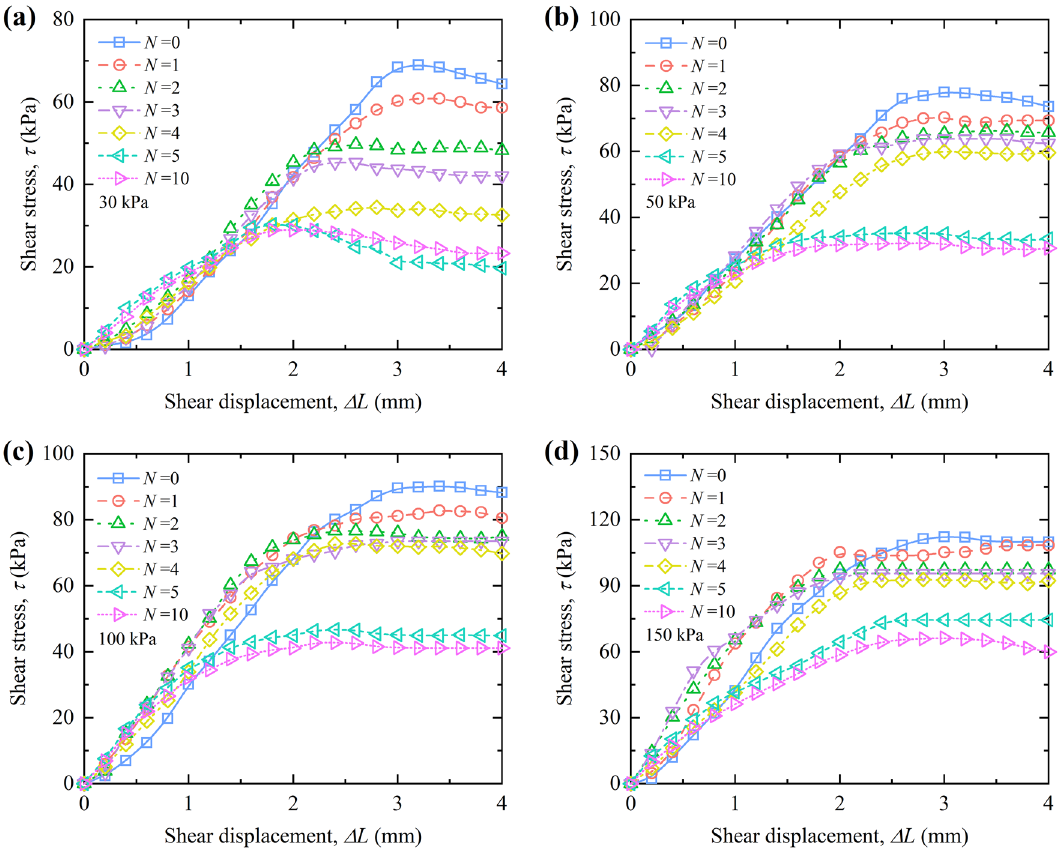
Figure 10. Shear stress versus shear displacement curves of RL under vertical